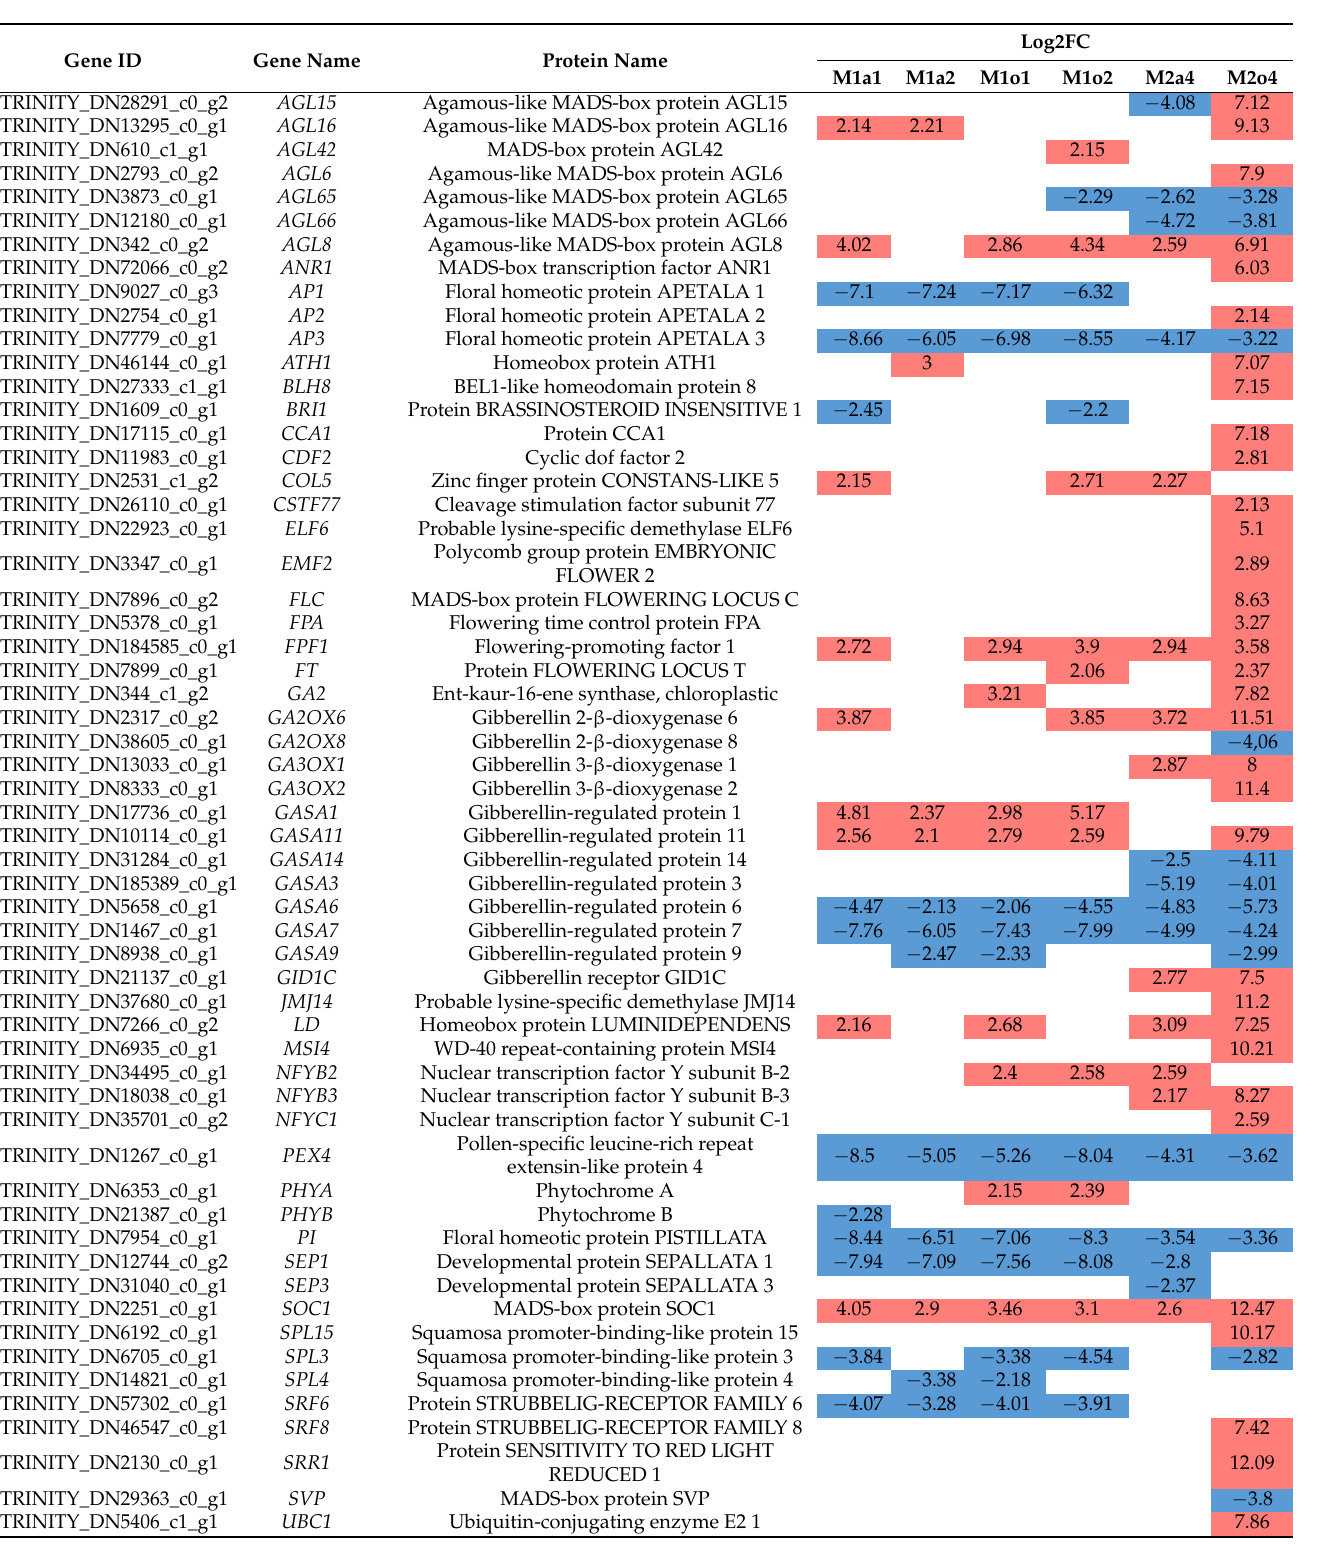
Table 4. List of florally differentially expressed genes (DEGs) in ovules of Limonium plants, namely apomictic L. multiflorum (M), sexual L. auriculifolium (a), and L. ovalifolium (o). DEGs were found in apomictic ovules in S1 relative to sexual ovules in S1 (M1a1 and M1o1) and S2 (M1a2 and M1o2), and in apomictic ovules in S2 relative to sexual ovules in S3/S4 (M2a4 and M2o4); (red: up-regulated DEGs; blue: down-regulated